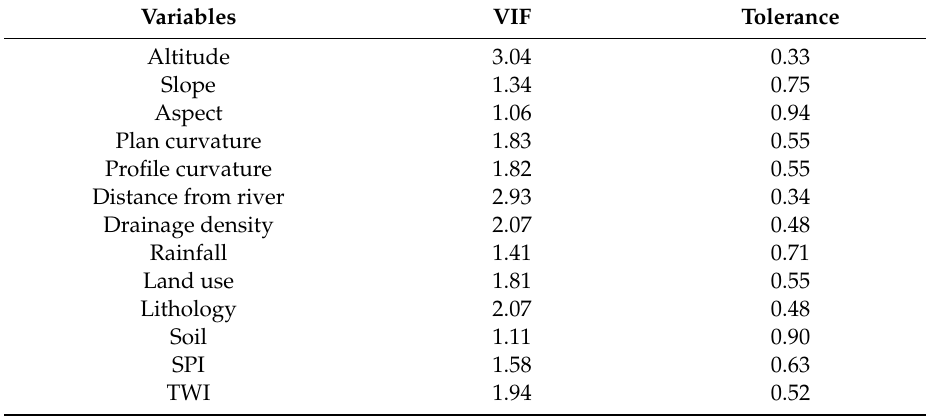
Table 3. Multi-collinearity analysis to determine the linearity of the independent